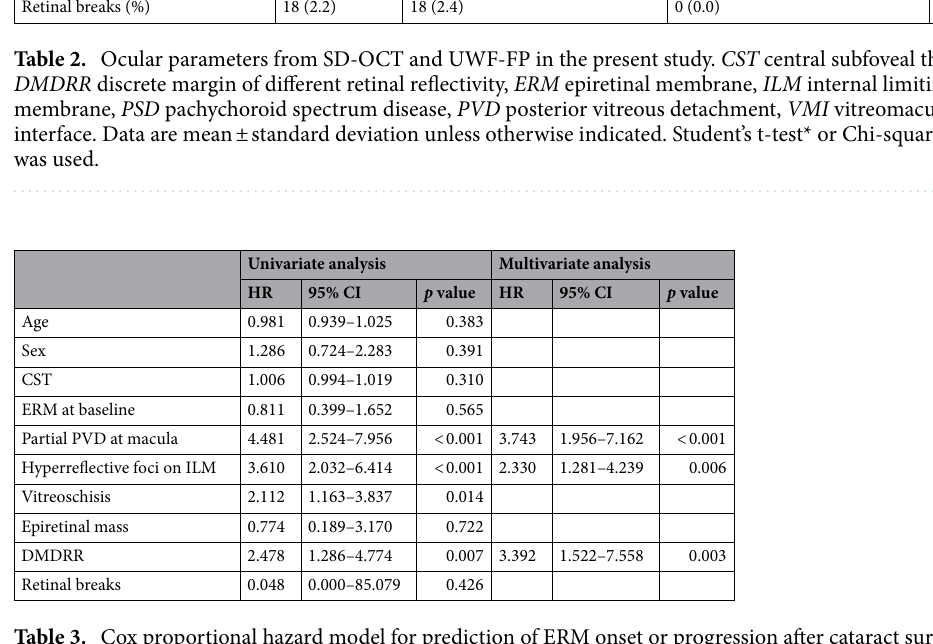
Table 3. Cox proportional hazard model for prediction of ERM onset or progression after cataract surgery. CST central subfoveal thickness, DMDRR discrete margin of different retinal reflectivity, ERM epiretinal membrane, ILM internal limiting membrane, PSD pachychoroid spectrum disease, PVD posterior vitreous detachment, VMI vitreomacular interface.